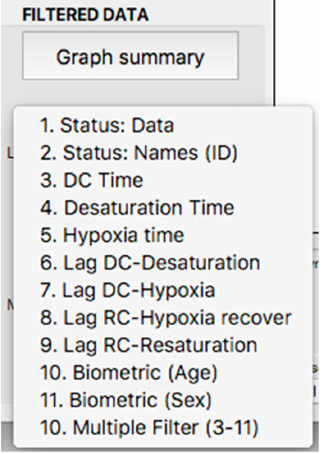
Figure 14. Visualization of the displayed panel with the types of flights performed in the hypobaric chamber.